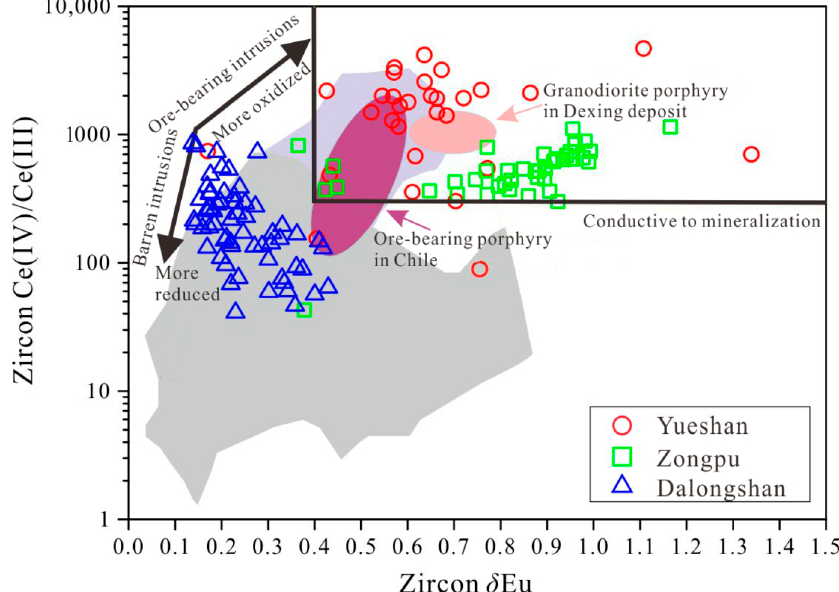
Figure 14. Ce(IV)/Ce(III) vs. δ Eu oxygen fugacity discrimination diagram of zircons from adakites and granites in the Anqing orefield. Background data are referred to [77,78].